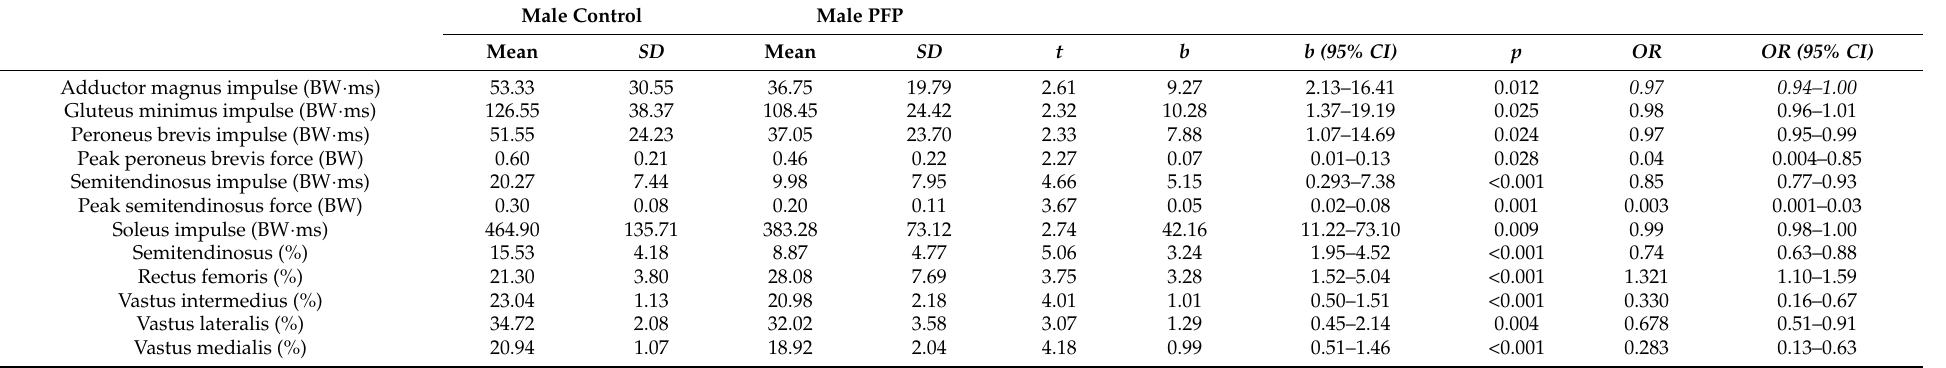
Table 6. Muscle force indices in male PFP participants and controls.